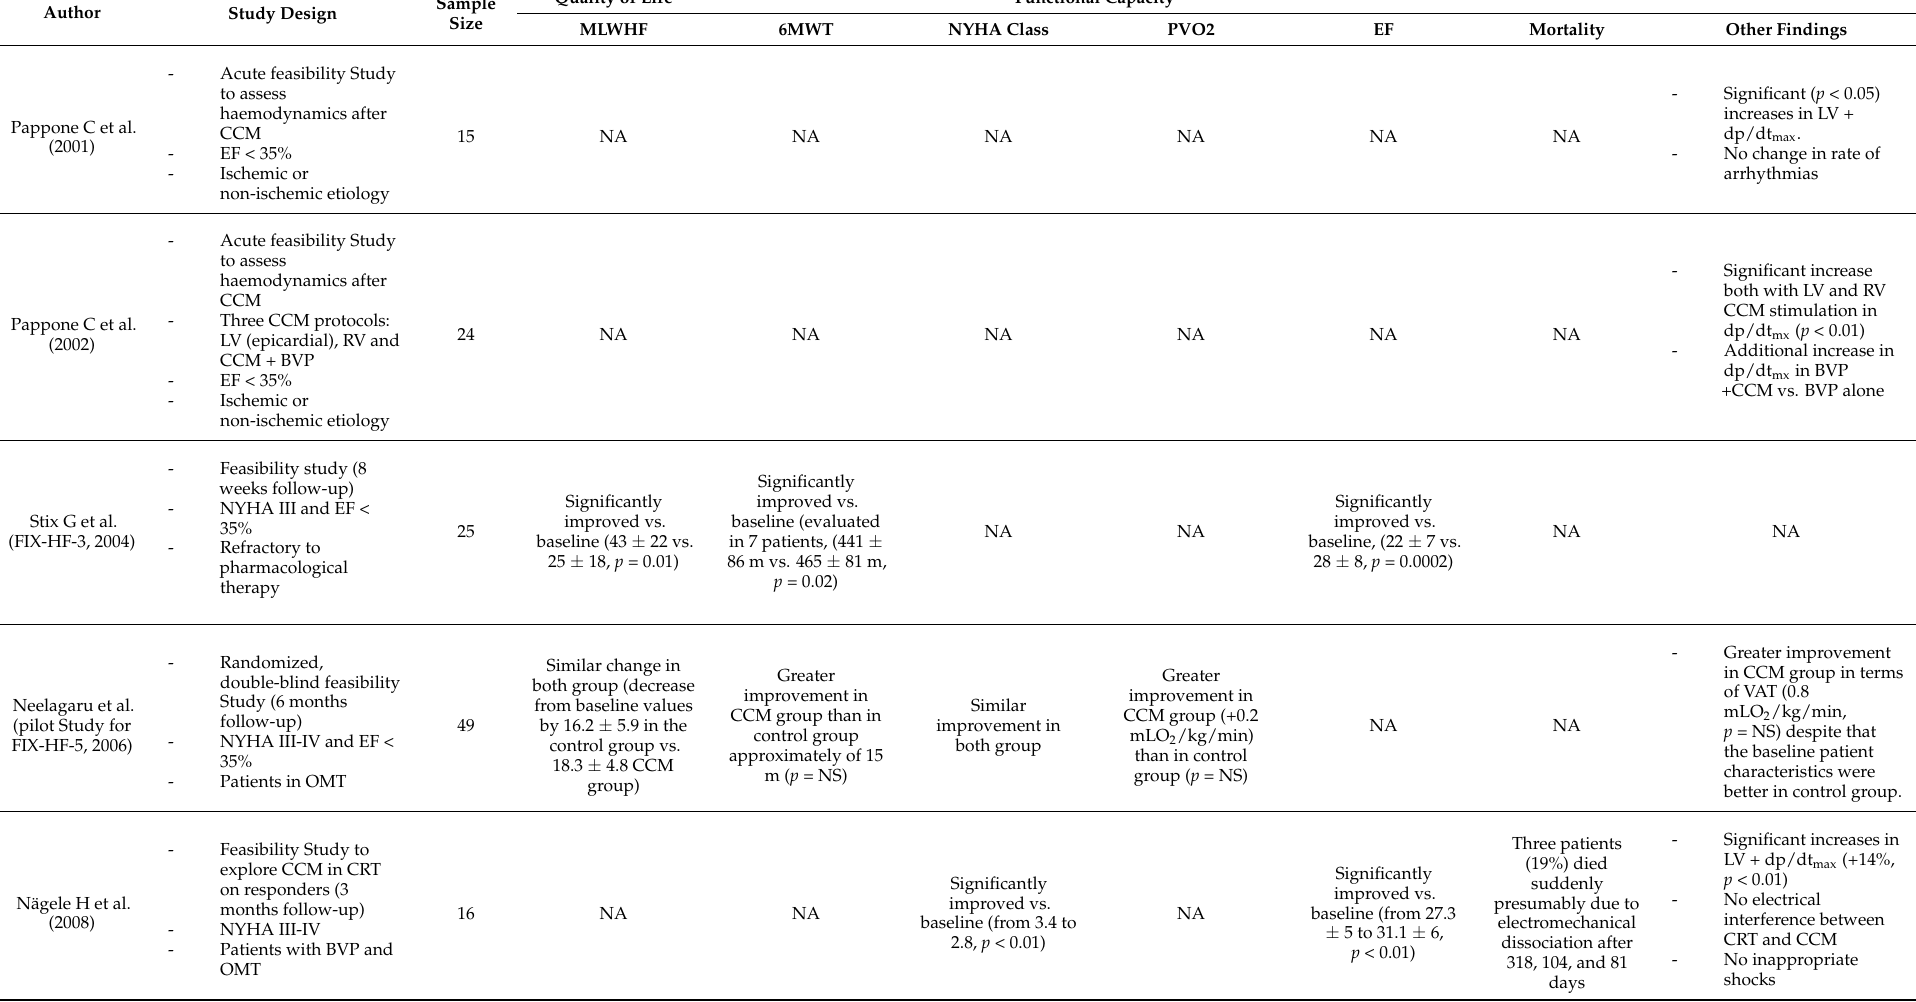
Table 1. Major findings and study design of clinical trials investigating